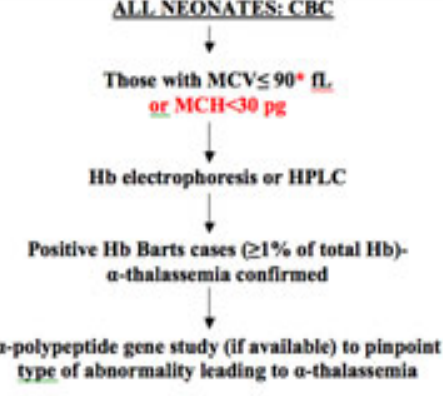
Figure 1. Investigational scheme for α -thalassemia screening of